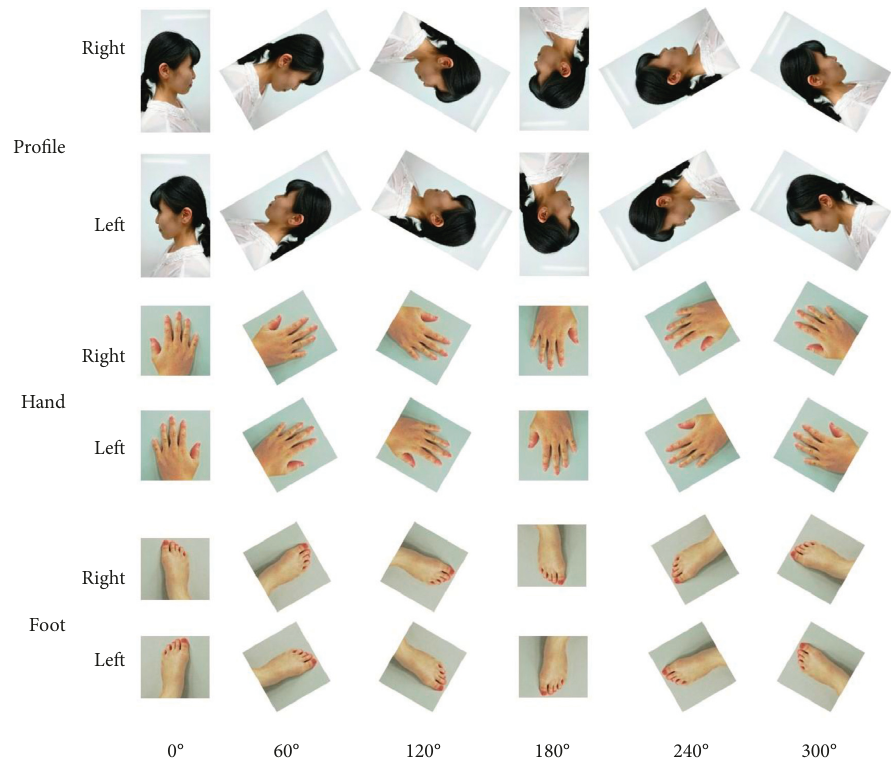
Figure 2: Photographic images of three types of experimental stimuli (profile, hand, and foot) in the six orientations (0 ° , 60 ° , 120 ° , 180 ° , 240 ° , and 300 ° ) used in mental rotation. Left stimuli were mirror images of right stimuli. Table 2: Mean RTs (msec) in the two groups for each stimulus type and